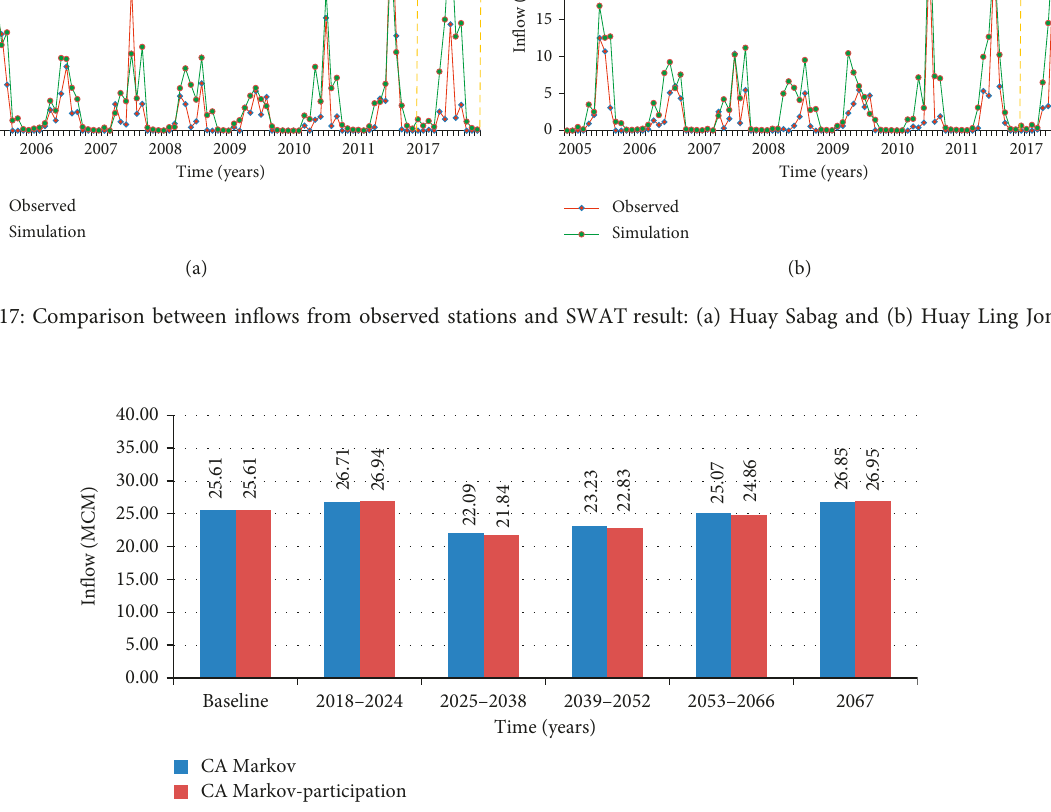
Figure 18: Baseline and future yearly inflow into Huay Sabag reservoir.